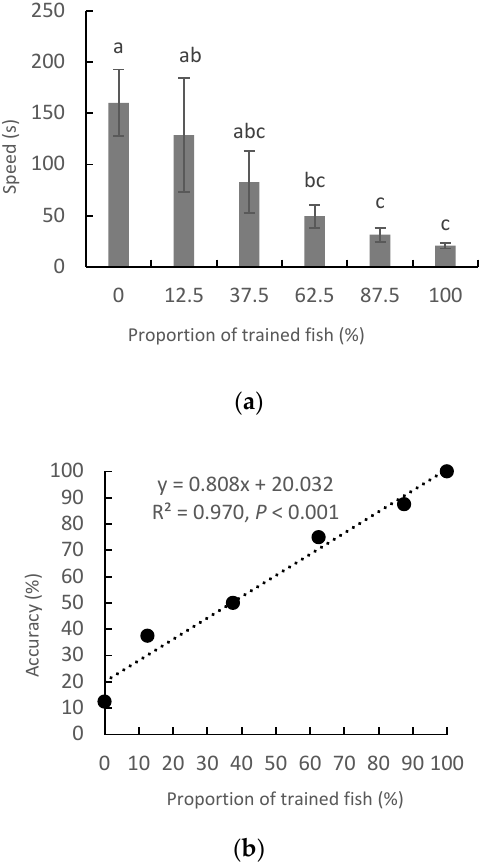
Figure 3. The speed ( n = 8) ( a ) and accuracy ( b ) of the majority of the fish in the group to reach the arm with food, with different proportions of trained individuals. Note: a, b, c, d letters suggest a significant difference of the variables after different days of training ( p < 0.05).